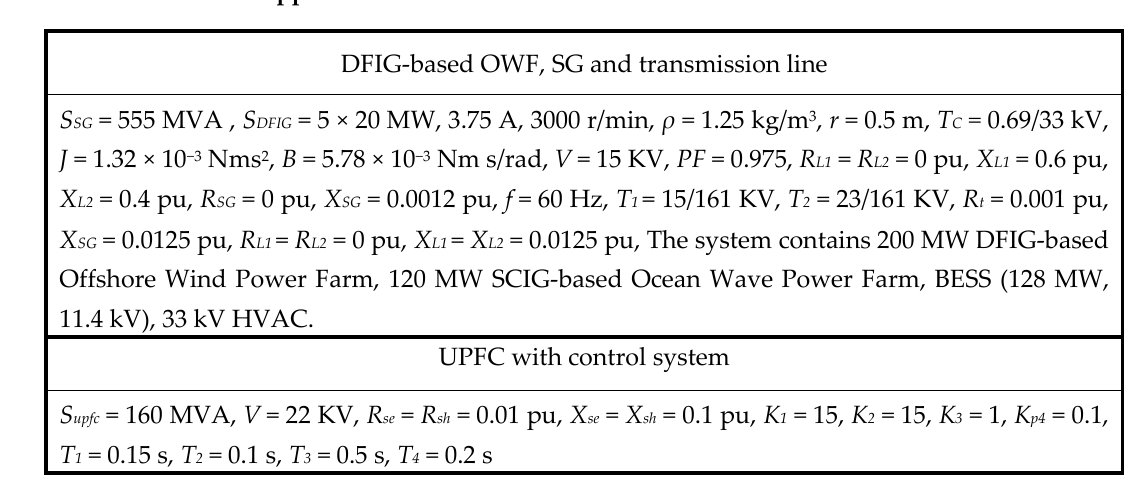
Figure A1. All parameters of HPS.